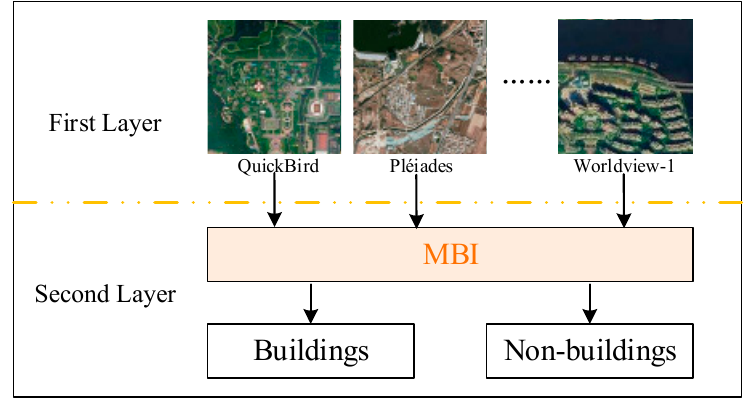
Figure 2. Framework of the proposed model.